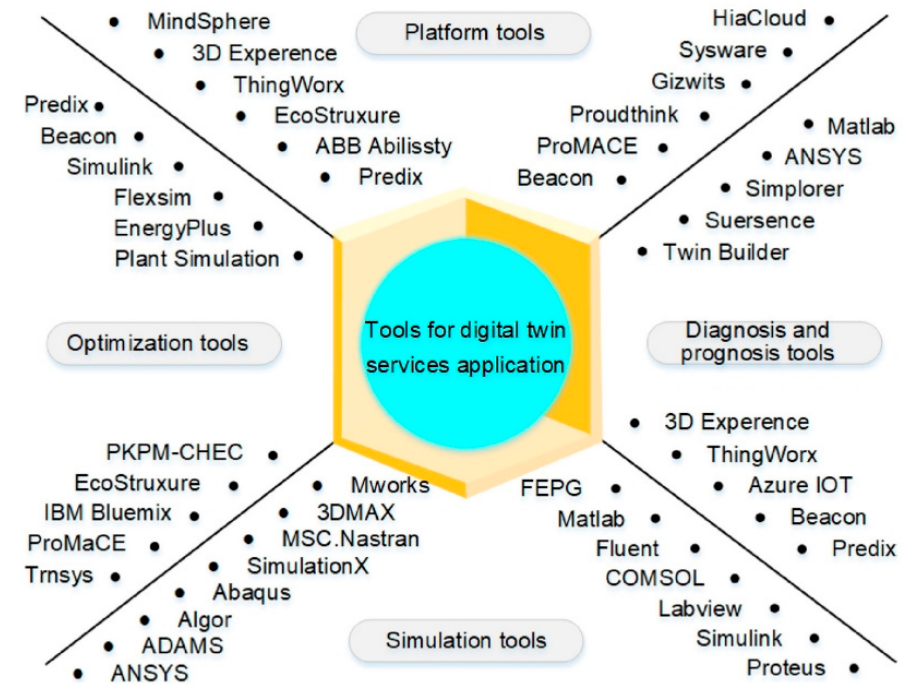
Figure 3. The tools for services applications of digital twins. Reproduced from [36], with permission from Elsevier, 2022.